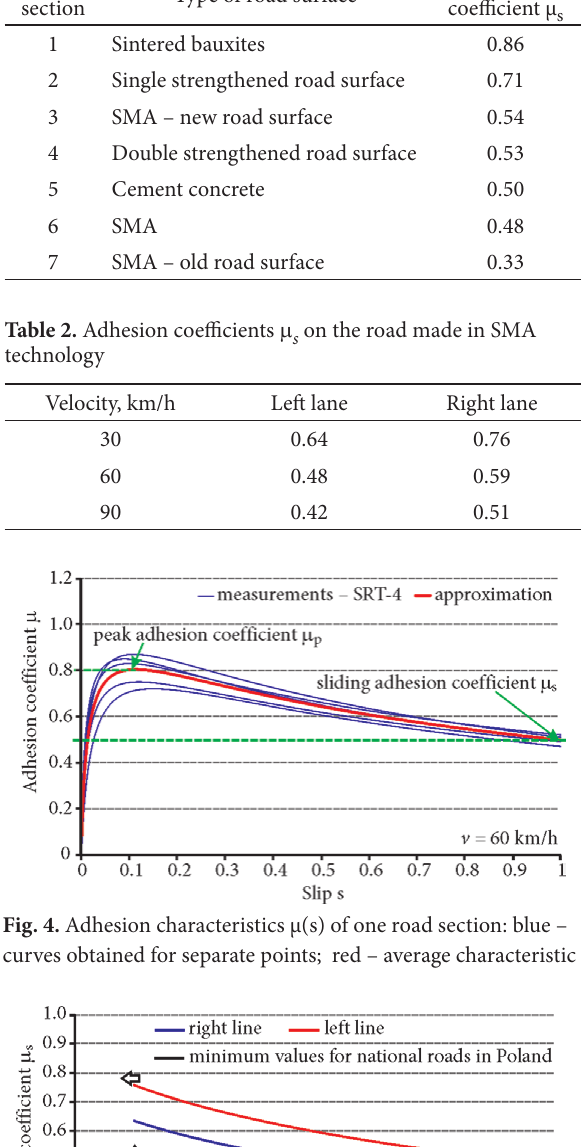
Table 1. Sliding adhesion coefficients µ s for different road surfaces. SMA – Stone Mastic Asphalt No. of section